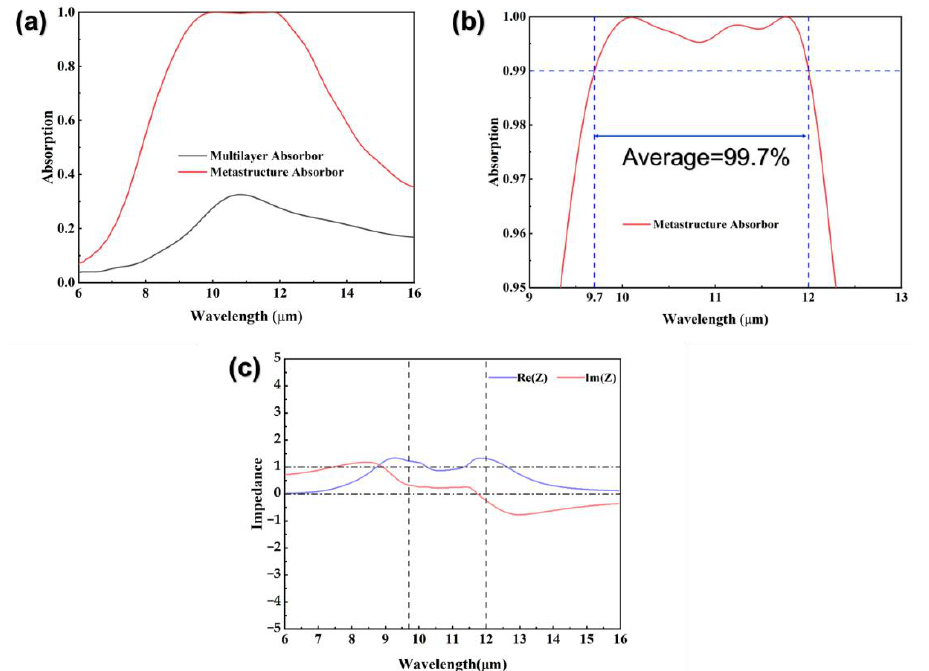
Figure 2. ( a ) Absorption spectrum diagram of the meta-structure absorber. ( b ) An enlarged view of the absorption spectrum. ( c ) Effective impedance of the meta-structure absorber in the working wavelength range.